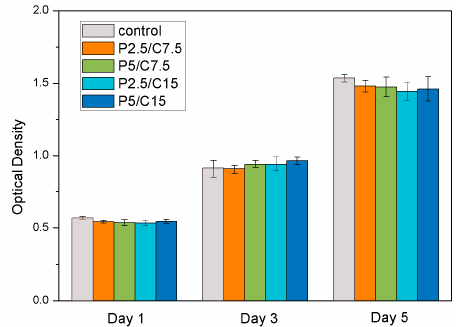
Figure 5. CCK-8 assay of MC3T3-E1 proliferation cultured in the conditioned medium containing different concentrations of KSL-W. (Data are shown as the means ± standard deviation, n = 4).